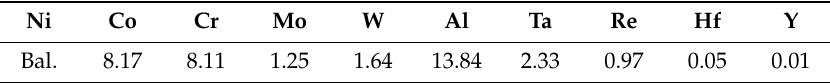
Table 1. Chemical composition of the single crystal superalloy N5 (in at.%).